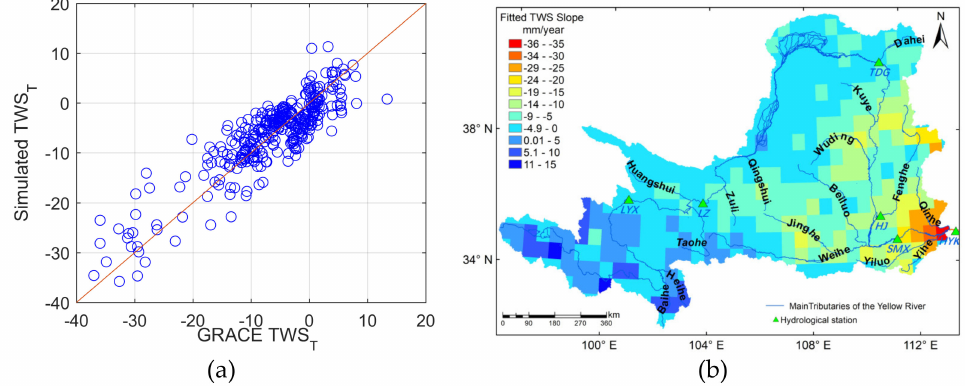
Figure 10. ( a ) Scatter plot for simulated TWS trend (TWS T ) and estimated ones by GRACE and ( b ) spatial distribution of TWS trend estimated by MARS model.